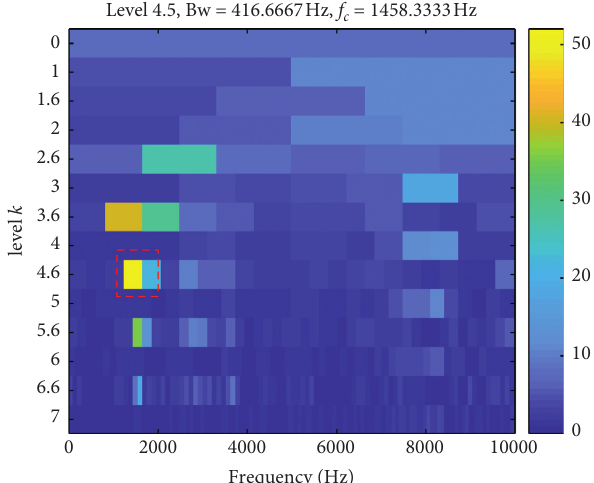
Figure 17: The colormap of data via fast computation of